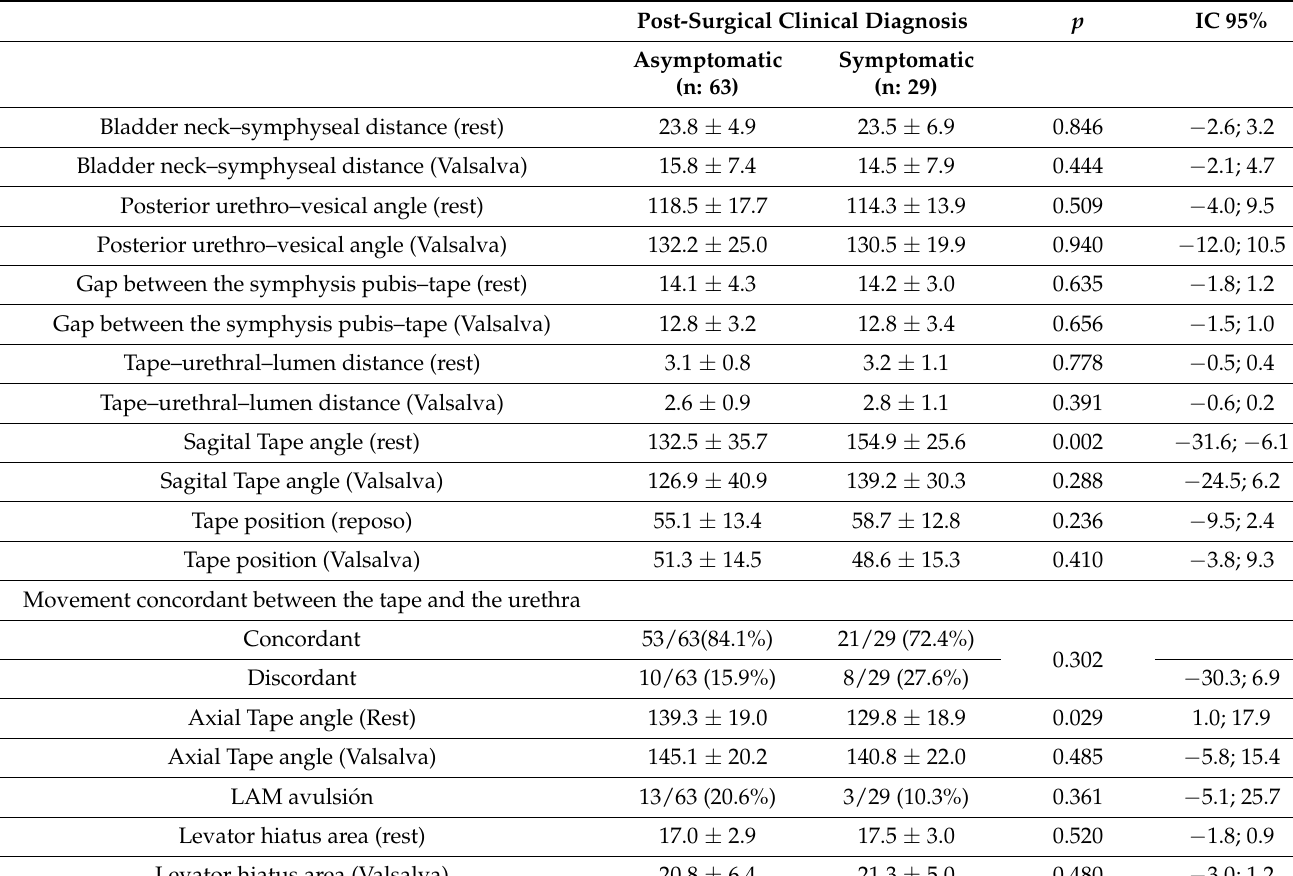
Table 2. Ultrasound evaluation of the study population differentiating asymptomatic from symp- tomatic patients after SIMS placement.